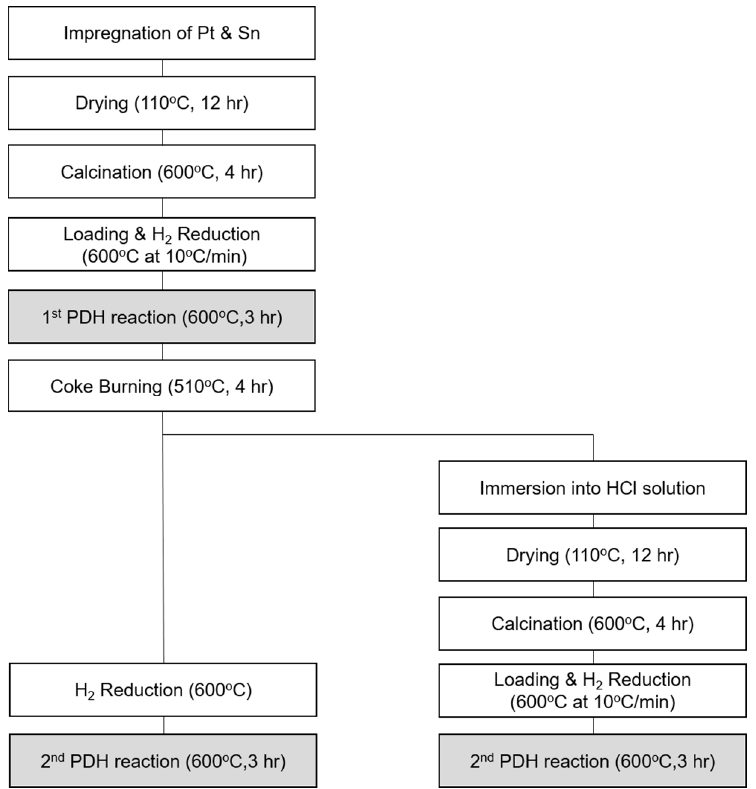
Figure 10. Diagram of the work scope of this study.